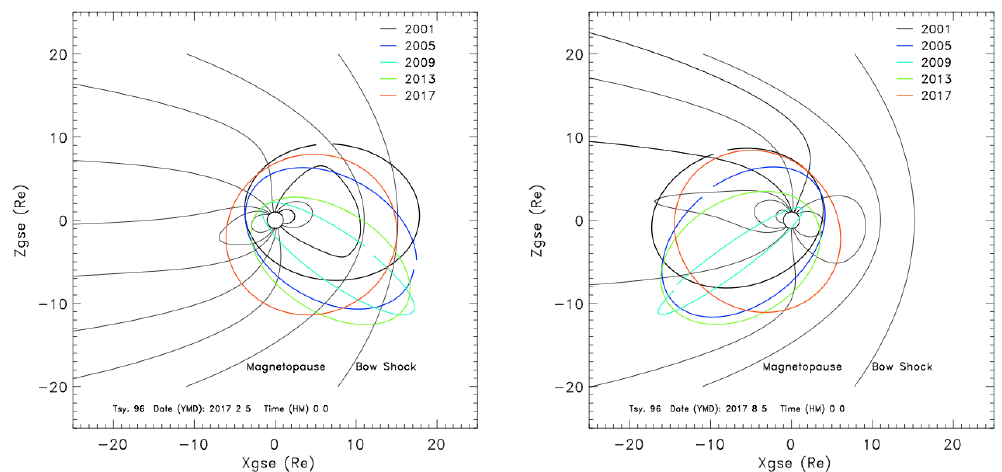
Figure 1. A broad sample of Cluster orbits from 2001 to 2017 in geocentric solar ecliptic (GSE) coordinates. The nominal magnetopause and bow shock positions as well as the magnetic field lines have been derived from the Tsyganenko 1996 model (date indicated at the bottom) and plotted as black lines. The orbit when the apogee is in the solar wind is shown on the left, and that when the apogee is in the magnetotail, 6 months later, is shown on the right. Note that the earlier years (2001–2005) show incomplete orbits since the orbital period (57h) was longer than in later years (54h).